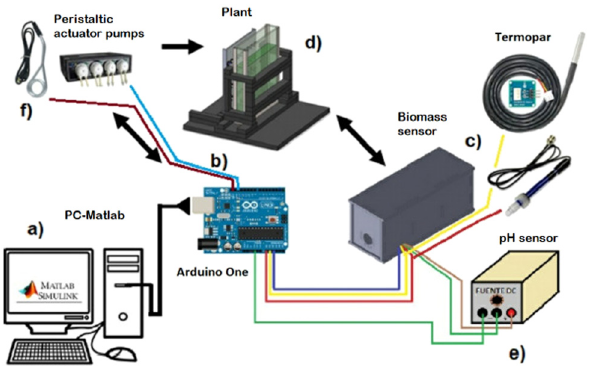
Figure 3: Integrated diagram of the control and monitoring system based on an Arduino – MATLAB interface consisting of the following parts ( a ) computer with USB – MATLAB connection; ( b ) Arduino One microcontroller; ( c ) biomass sensors based on turbidity and temperature sensors ( LM35 ) , and potentiometer electrode for measuring hydrogen potential; ( d ) culture photobioreactor of Spirulina platensis ; ( e ) power stage; and ( f ) control actuators ( pumps and resistor ) of the bioprocess.